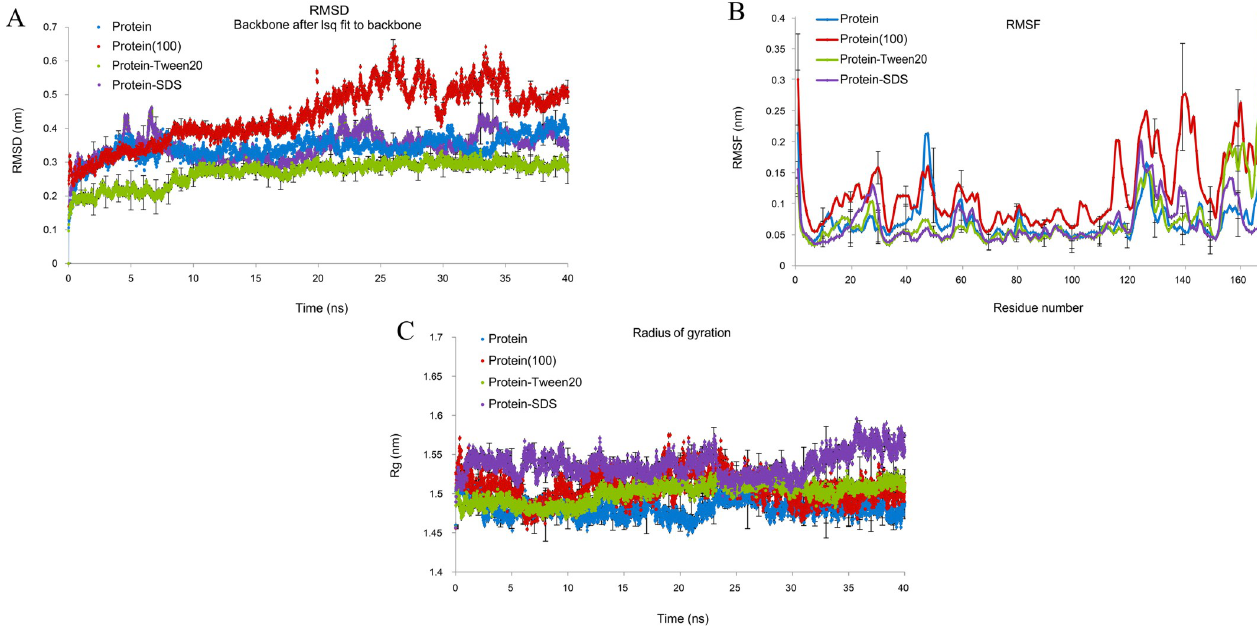
Fig 7. MD simulation of protease 1147 alone and in complex with Tween 20 and SDS. (A) RMSD graph, (B) RMSF graph, and (C) Rg Protease 1147 in the water environment (black), protease 1147-Tween20 complex (green), protease 1147-SDS complex (blue) and protease 1147 at 100˚C temperature. The approximate positions of active site amino acids are shown in the RMSF plot. The simulations were run in triplicate to obtain average values. The error bars represent standard deviations and are depicted for every 10 ps.